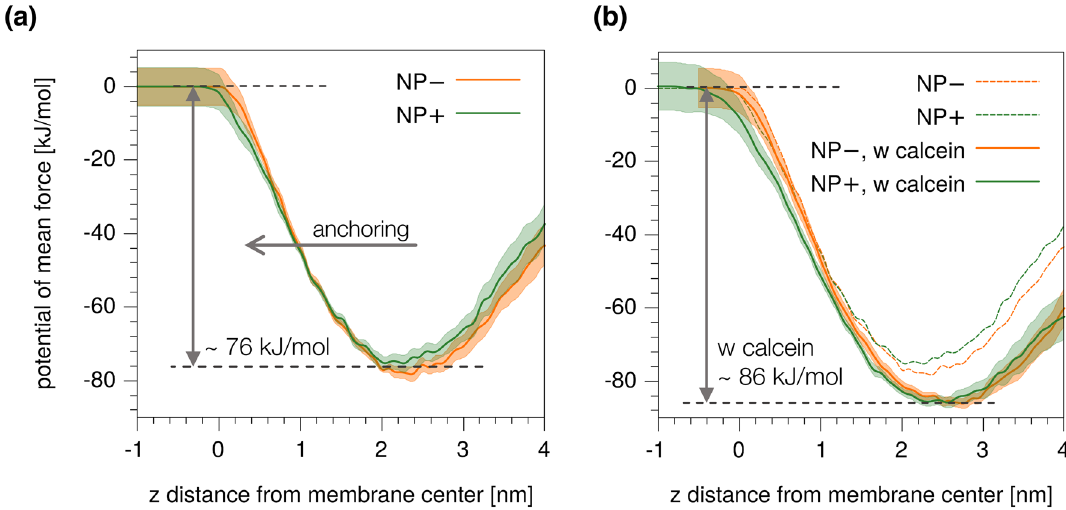
Figure 4. Potential of mean force for the translocation of a single charged ligand, bound to the NP, from the entrance to the distal leaflet. On the x - axis, we report the collective variable of the metadynamics runs, which is the z component of the distance between the charged terminal of the biased ligand and the centre of mass of the membrane. ( a ) Without calcein. ( b ) Comparison with and without calcein. The shaded area corresponds to the standard error; in ( b ) are reported only the error for the case with calcein only, for readability. See Ref. 54 for details on the standard error